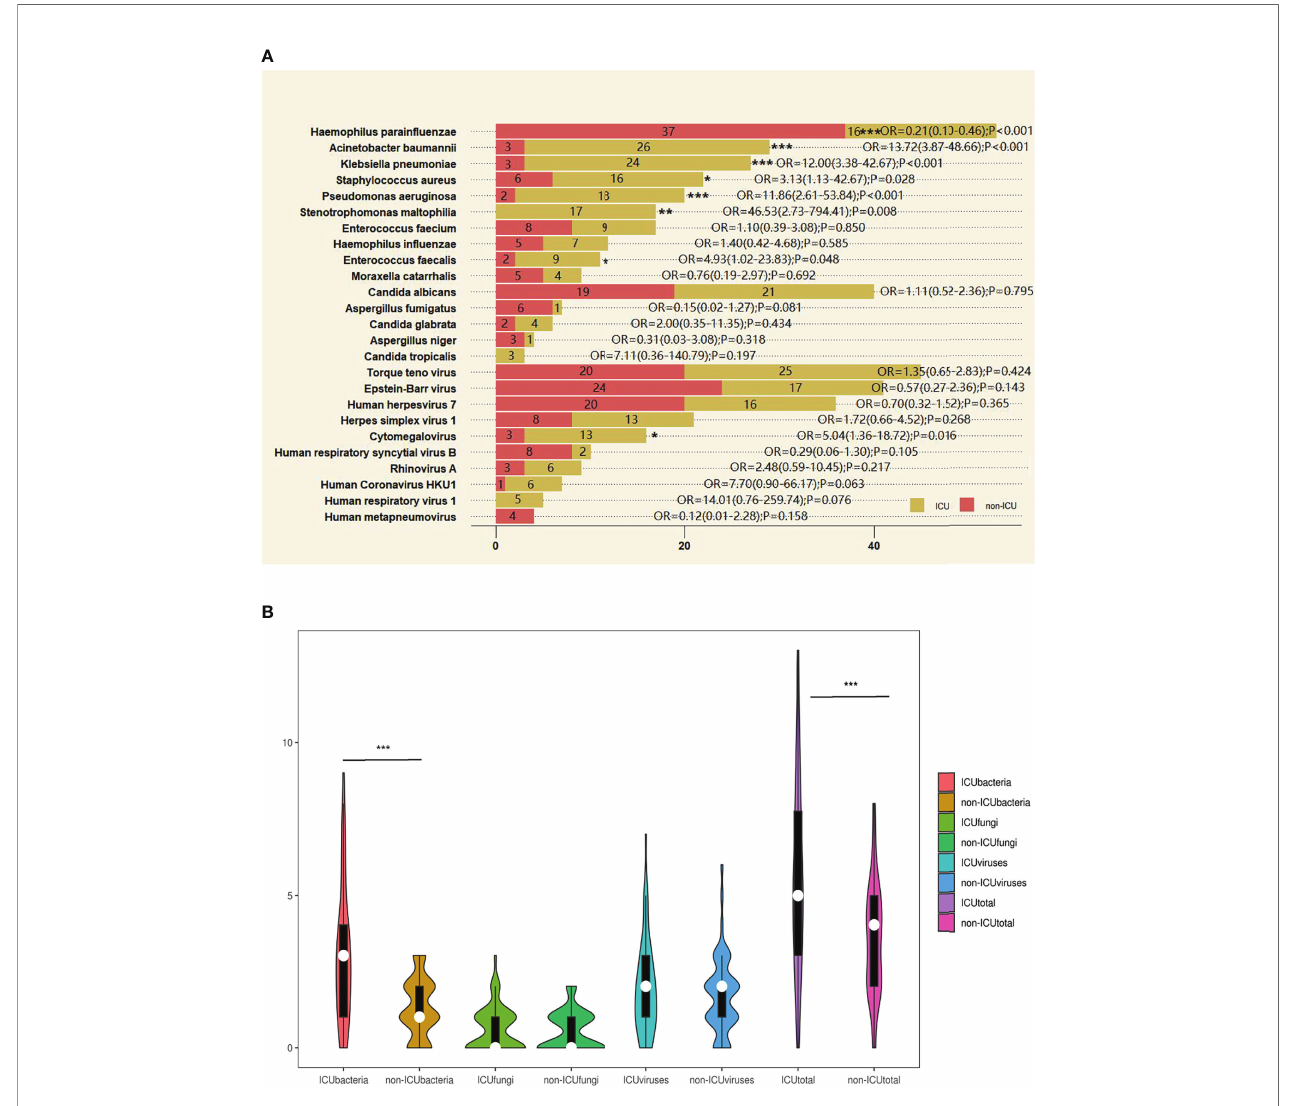
FIGURE 3 | The overlap of metagenomic next-generation sequencing (mNGS) positivity between intensive care unit (ICU) and non-ICU groups for different pathogens. (A) The most common bacteria, fungi, DNA viruses, and RNA viruses were detected by mNGS method between ICU and non-ICU groups. The 10 most common bacteria and the 5 most common fungi, DNA viruses, and RNA viruses were detected by mNGS method between ICU and non-ICU groups. The last 5 viruses were RNA viruses detected by RNA sequencing. Ten ICU cases did not complete RNA sequencing. Other pathogens were detected by DNA sequencing. Tests used Z test. (B) Violin plot of bacteria, fungi, viruses, and all pathogens detected by DNA and RNA sequencing between ICU and non-ICU groups. After Shapiro – Wilk tests, they did not follow normal distribution; tests used Mann – Whiney U test. *p < 0.05, **p < 0.01, ***p < 0.001. OR, odds